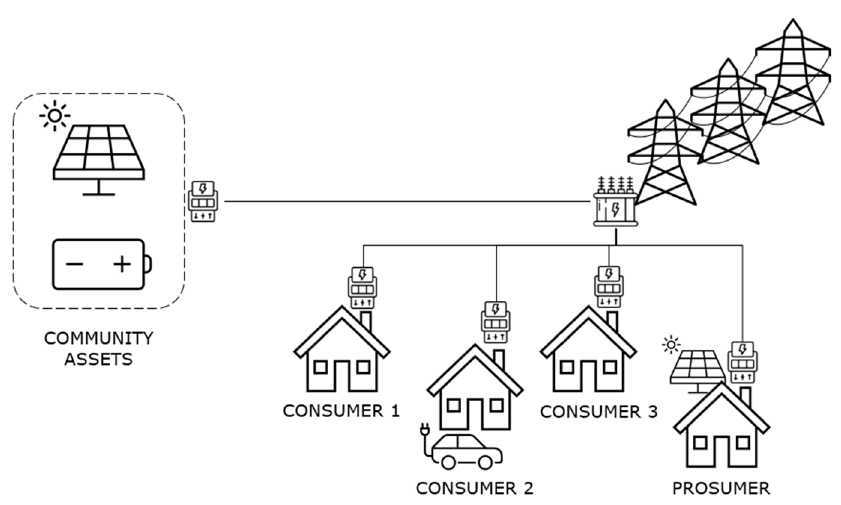
Figure 1. LEC organised as Energy